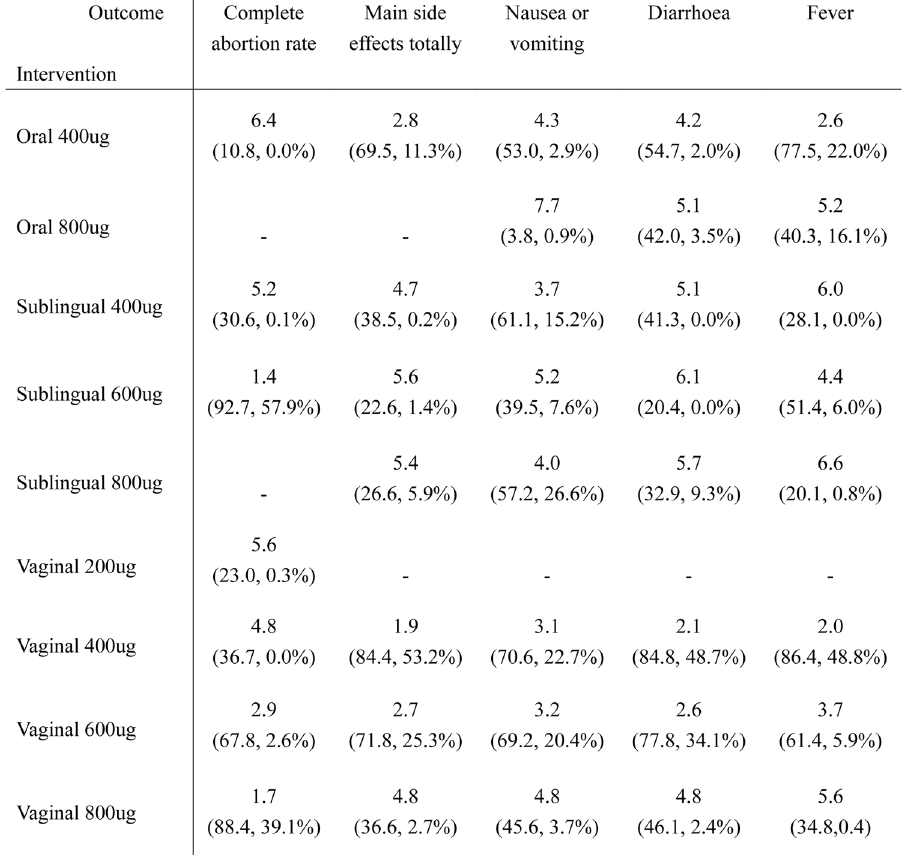
Figure 4. Ranking of all the interventions in network meta-analysis. Information of ranking is located at the intersection of the column-defining outcome and the row-defining intervention; The number in the first row is the ranking of all the interventions; The first number below in brackets is the surface under the cumulative ranking curve (SUCRA) while the second is the probability of the intervention to be the